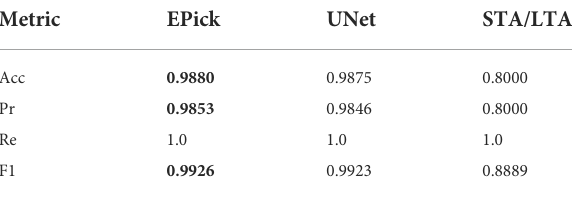
TABLE 2 First phase arrival-time picking on the test dataset from the STEAD dataset (Mousavi et al., 2019). μ and σ are the mean and standard deviation of the arrival time errors (prediction-ground truth) in seconds, respectively. Pr, Re, and F1 are precision, recall, and F1- score, respectively.